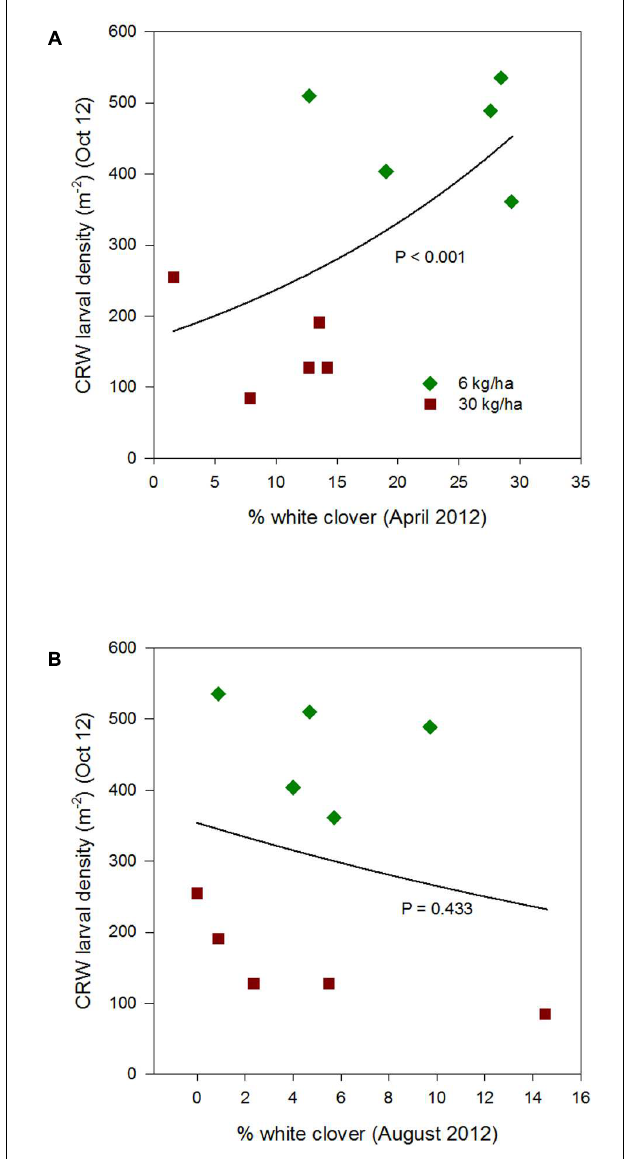
FIGURE 3 | Clover root weevil larval densities measured in October 2012 in relation to % white clover measured in April 2012 (A) and August 2012 (B), from ryegrass plots (cv. Nui) sown at 6 and 30 kg/ha (solid line shows the estimated relationship across all plots, irrespective of ryegrass sowing rate).